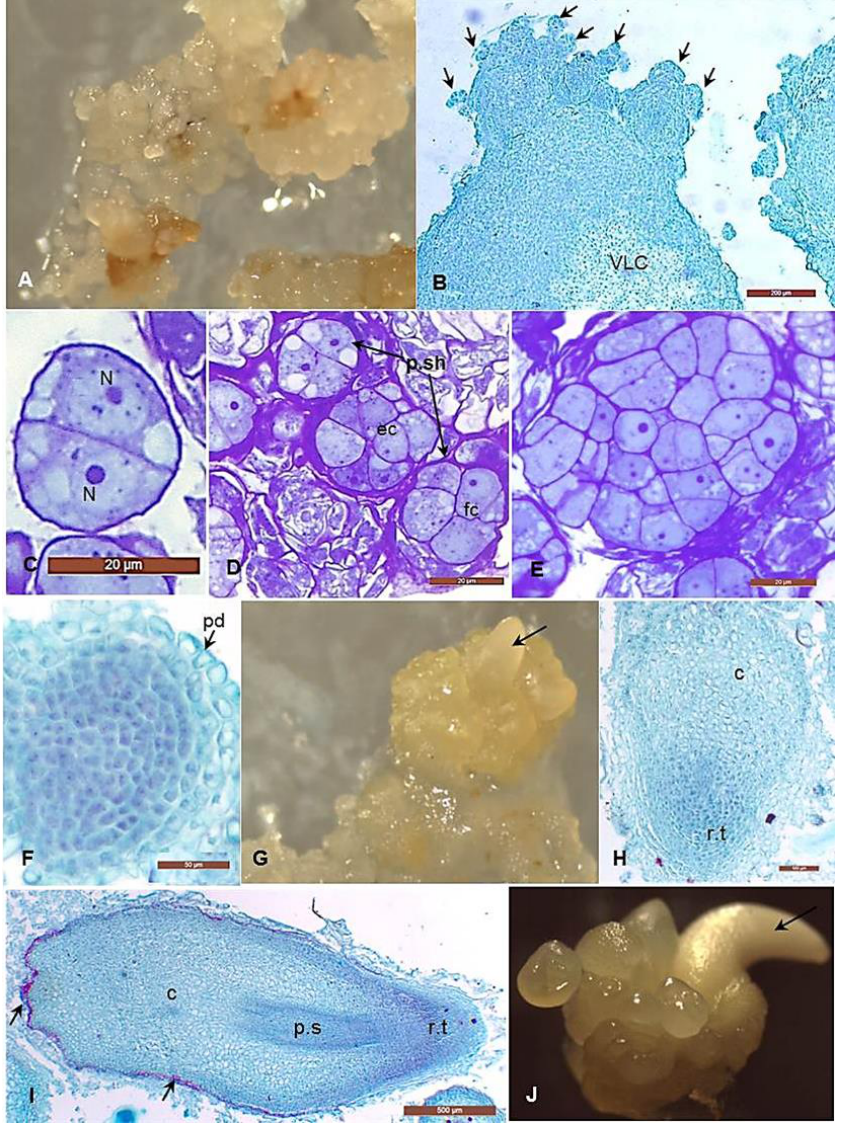
Figure 3. Morphological and histological analyses of embryogenic callus (EC) and the successive developmental stages of somatic embryos of Phoenix dactylifera cv. Barhee. ( A ) Morphology of em- bryogenic callus. ( B ) Transverse section of EC showed several disorganized callus masses composed of two types of cells: more vacuolated large cells (VLC) occur in the central part and multiple meri- stematic clumps (arrows) with visible fragmentation lines. ( C, D & E ) semi-thin sections in the mer- istematic aggregates showed the presence of the first embryogenic stages. ( C ) The two-celled pro- embryo with two large nuclei (N), ( D ) The four-celled (fc) and the eight-celled spherical (ec) pro- embryos. Note the clear, visible polysaccharide sheath (p.sh) surrounding these pro-embryonic stages. ( E ) The active cell divisions yield the multicellular globular embryo. ( F ) Early stage of the bipolar embryo; note the protoderm initial (pd). ( G ) The bipolar embryo protrudes from the